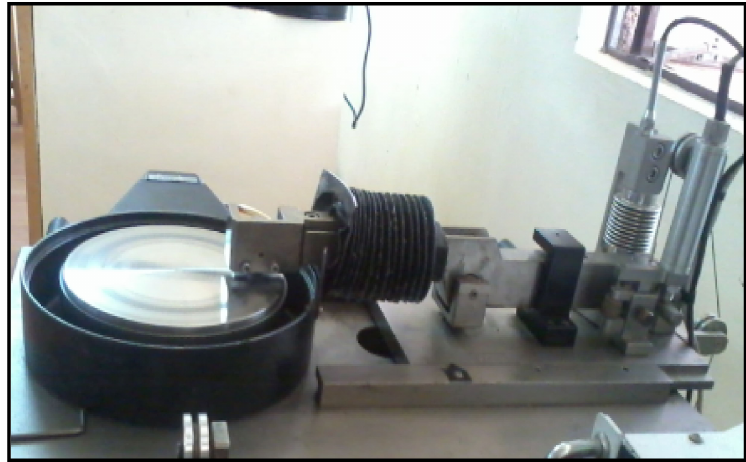
Figure 4. Schematic view of dry sliding wear test